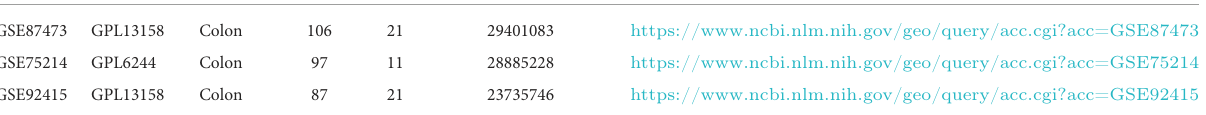
TABLE 1 Details of gene expression profiles. Dataset Platform Tissue Normal UC Reference (PMID) Hyperlinks